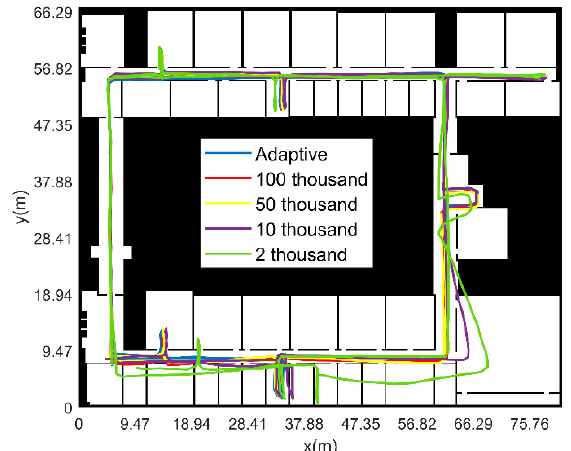
Figure 19. Pedestrian motion trace calculated with different particle numbers under experimental conditions.